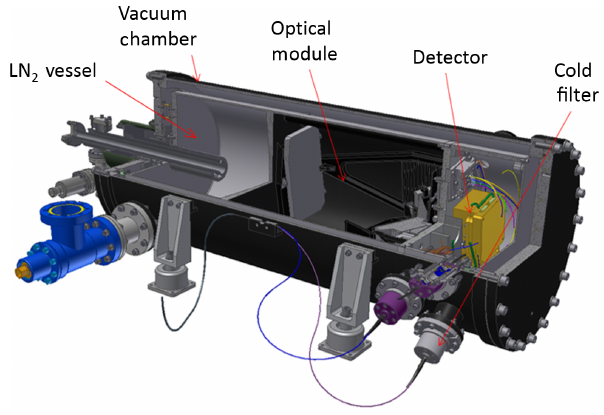
Figure 5. GHOST spectrometer module showing the front end com- partment, the main spectrometer optics area, and the liquid nitro- gen cryogenic vessel. The cylinder containing these components is 1064mm long and 440mm in diameter. Taking into account the fit- tings external to the cylinder, the space occupied is 1406mm long, 758mm wide, and 440mm